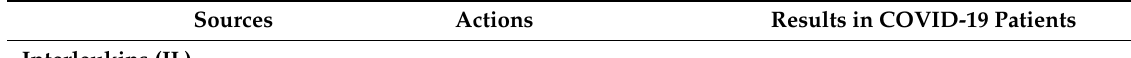
Table 2. An overview of cytokines involved in cytokine storm by